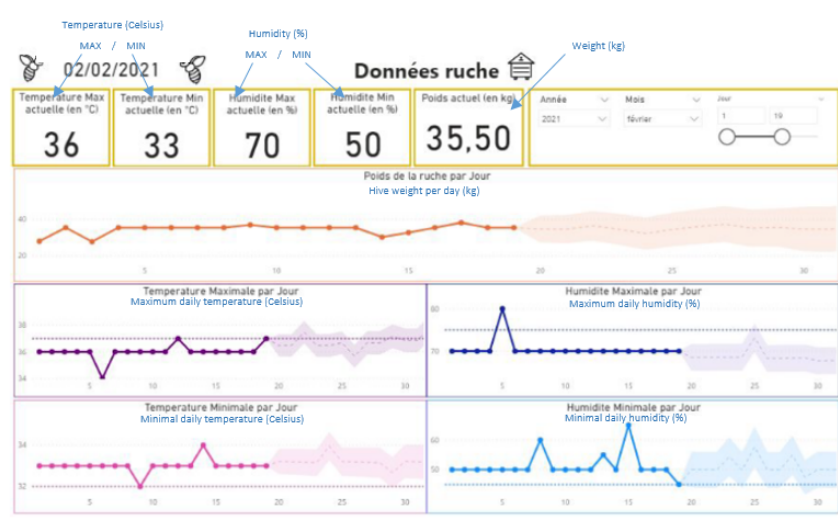
Figure 11. Dashboard: